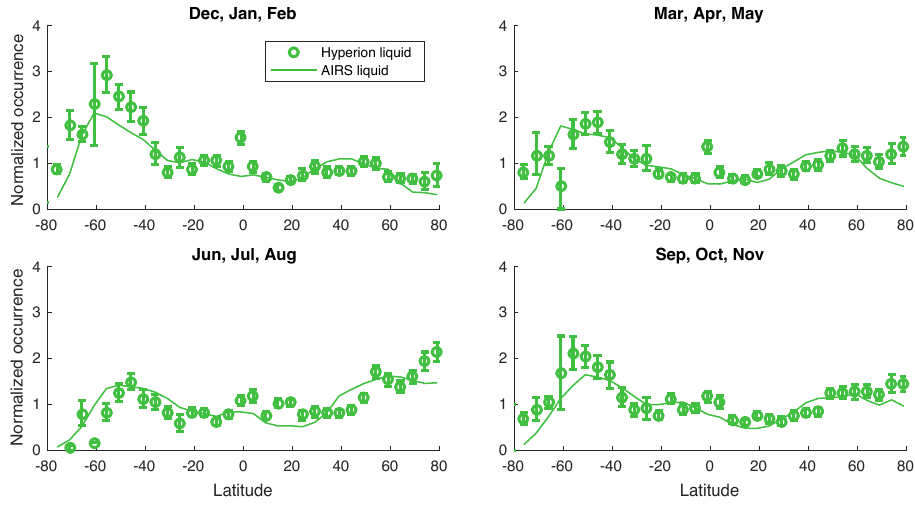
Figure 7. Comparison of Hyperion and AIRS cloud statistics, both normalized by the − 60 to 60 ◦ latitude range to account for differences in cloud mask cutoff thresholds. The 10-year seasonal observations are shown separately for the liquid phase. Here Hyperion uses a hard classification; i.e., liquid thickness fractions less than 0.5 are considered ice clouds. Error bars show 95% confidence intervals calculated via nonparametric bootstrap estimation. The corresponding AIRS error bars would be far smaller due to the large number of samples, so we omit them for clarity.